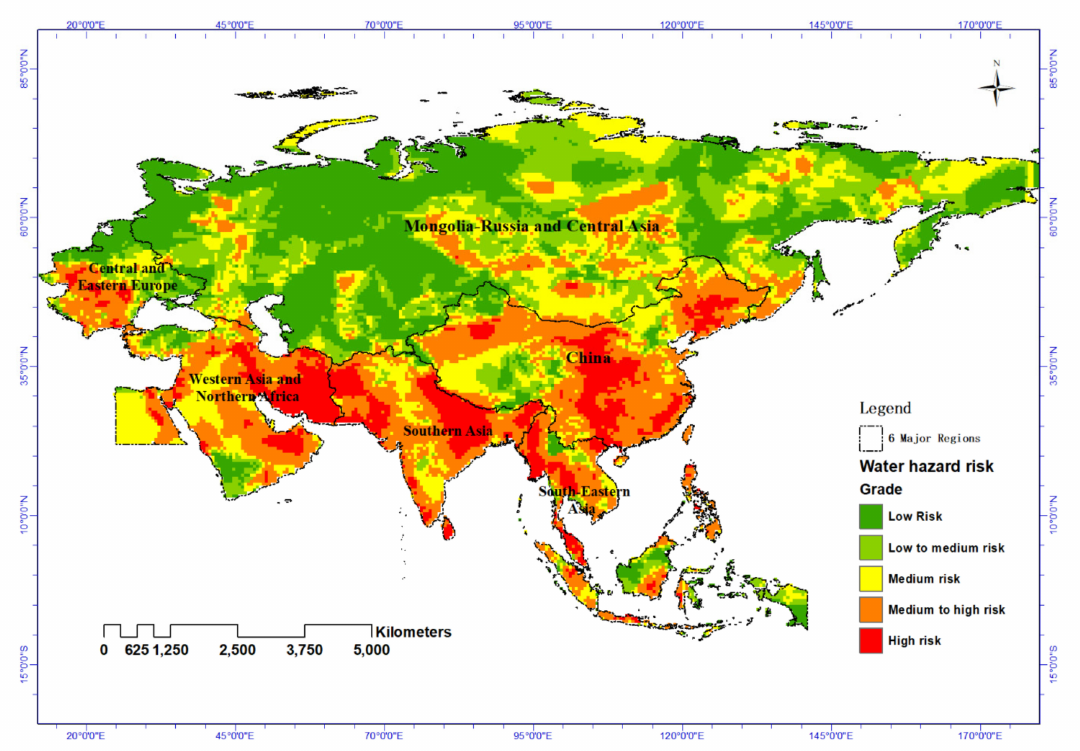
Figure 8. Water hazard risk